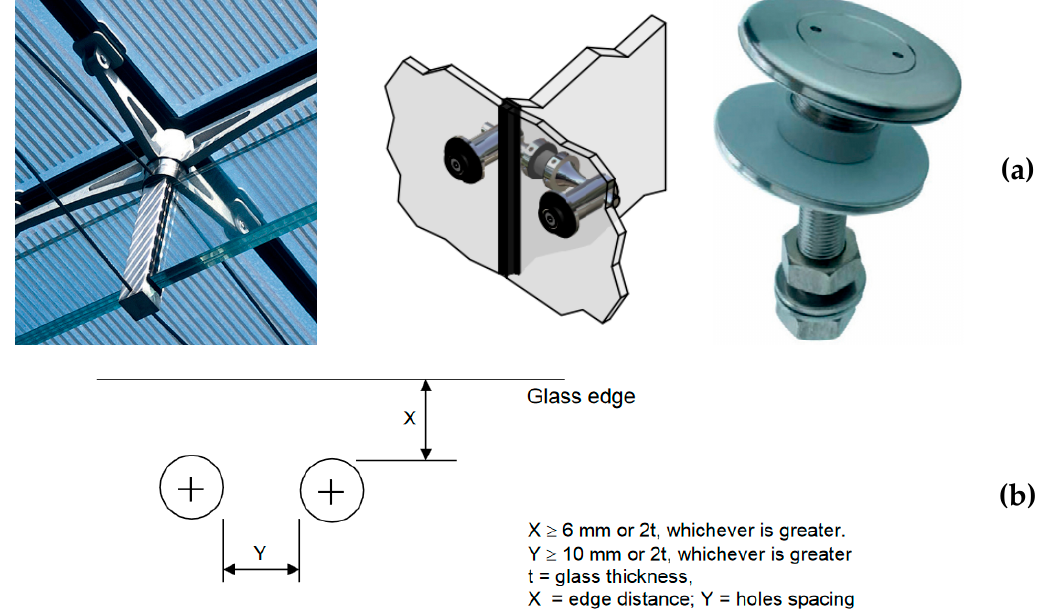
Figure 6. LR glass beams with discrete mechanical lateral restraints: ( a ) examples of point fixings and ( b ) schematic representation of minimum distance requirements for the glass holes.